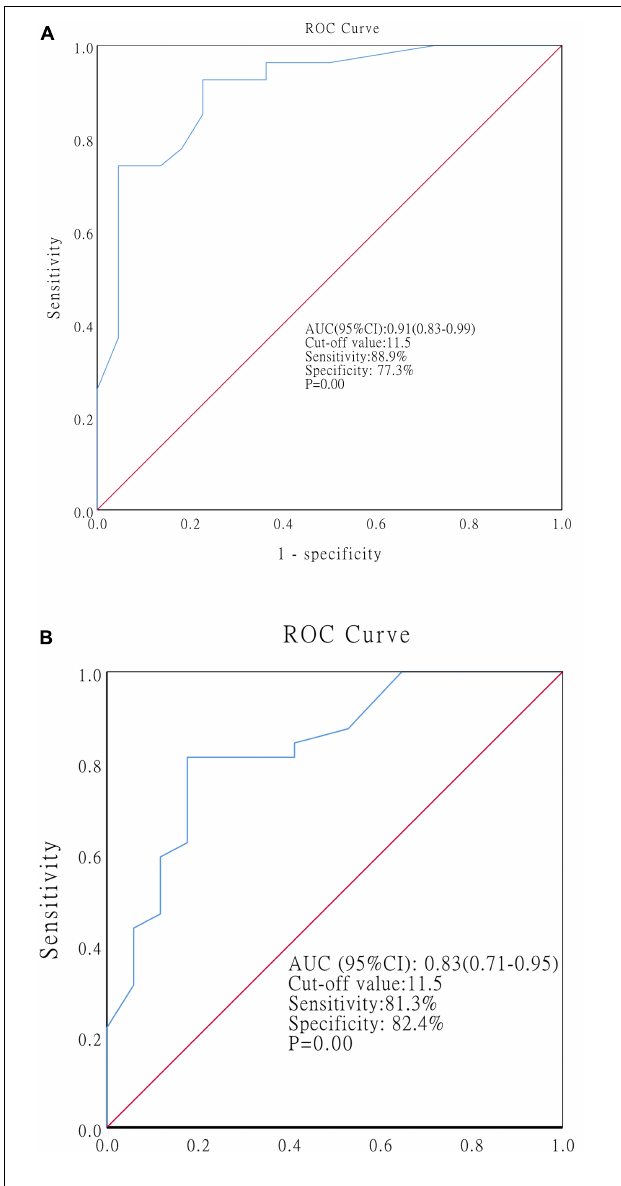
FIGURE 4 | ROC curves showing the optimal cutoff value of the SES-CD at baseline for predicting MH at the end of EEN (A) and at 1-year post-EEN (B) . Abbreviations: ROC, receiver operating characteristics; SES-CD, simple endoscopic score for CD; MH, mucosal healing; EEN, exclusive enteral